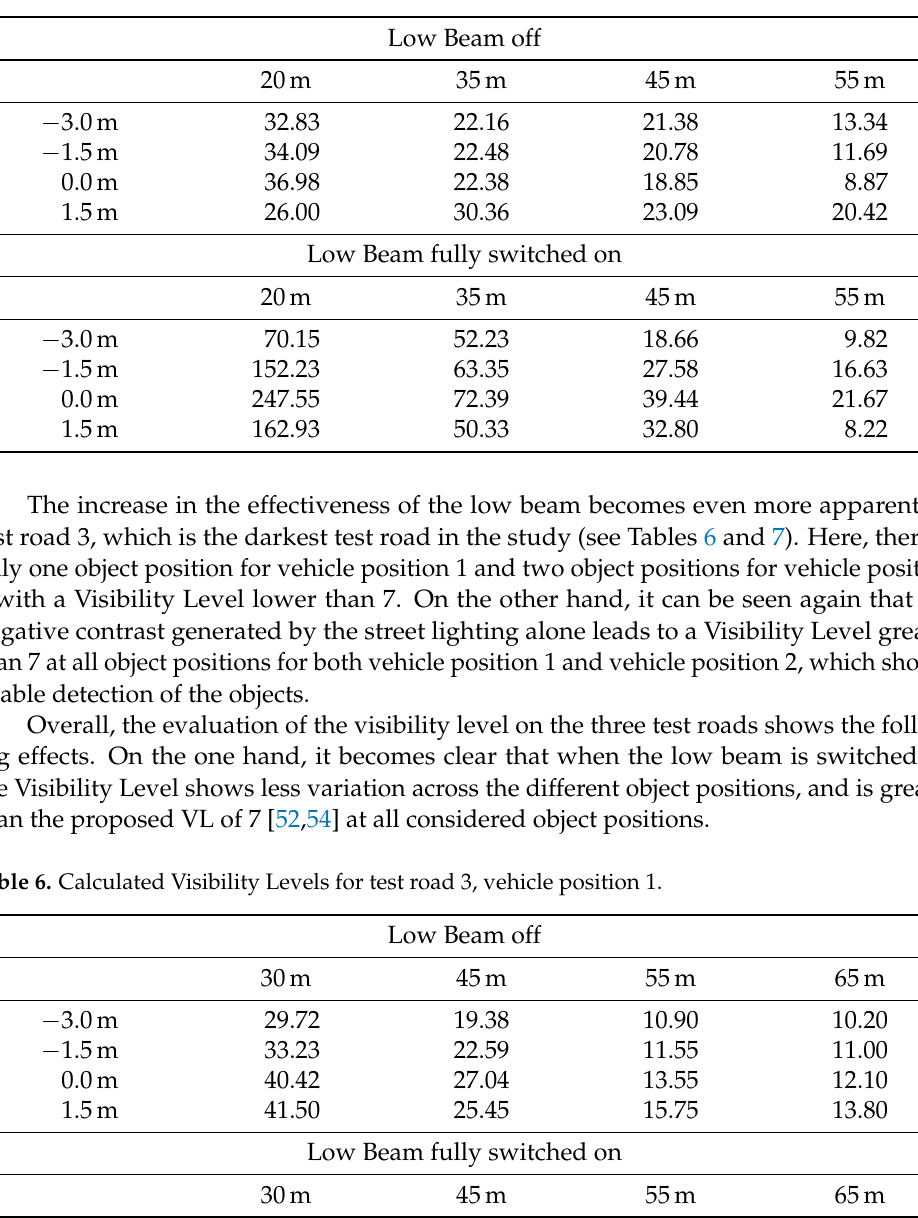
Table 5. Calculated Visibility Levels for test road 2, vehicle position 2.